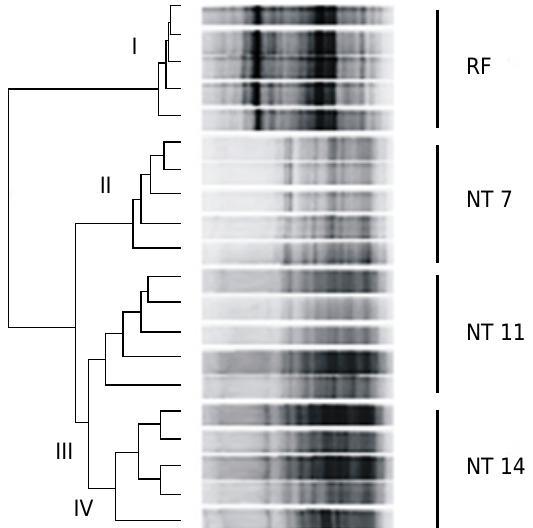
Figure 3. Dendrogram (UPGMA) of 16S rRNA gel DGGE profiles of the soil bacterial communities analyzed in the experiment (five replications per area). Clusters were defined at 50 % similarity level. RF = reference area (murundus field); NT7 = area converted into no-tillage system for 7 years; NT11 = area converted into no-tillage system for 11 years; NT14 = area converted into no-tillage system for 14